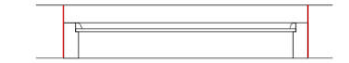
Figure 8. General structure of a window element.